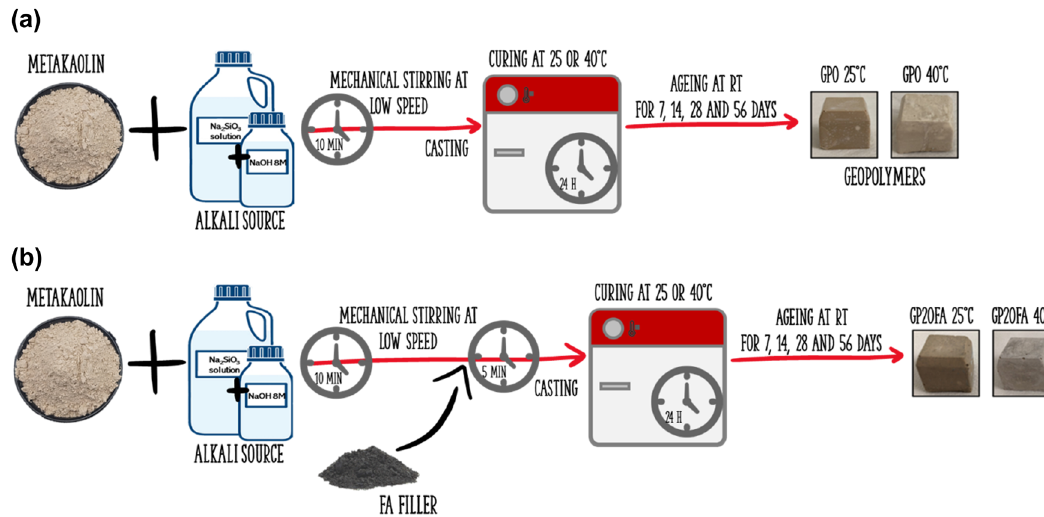
Figure 1: Flow chart showing the procedure of the GP synthesis without ( a ) and with ( b ) FA fi